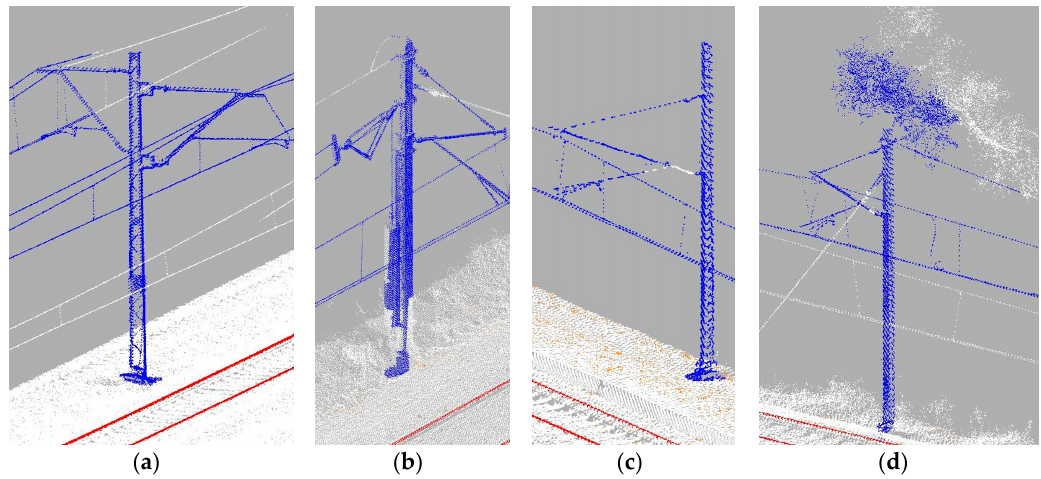
Figure 16. Detected and classified support structures: correct classification ( a ), support structure with additional wire stretchers ( b ) (Category I), support structure with cantilevers constructed with thin steel cables ( c ) (Category II), support structure with incorrectly-classified greenery ( d ) (Category III). Blue, catenary class, red, rail class, orange, ground class, white, remaining points.